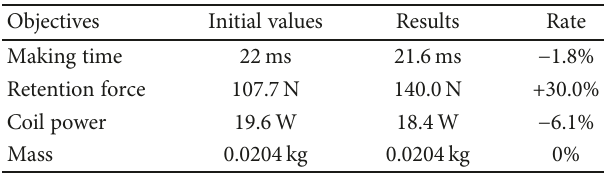
Table 4: The fi nal optimal results.